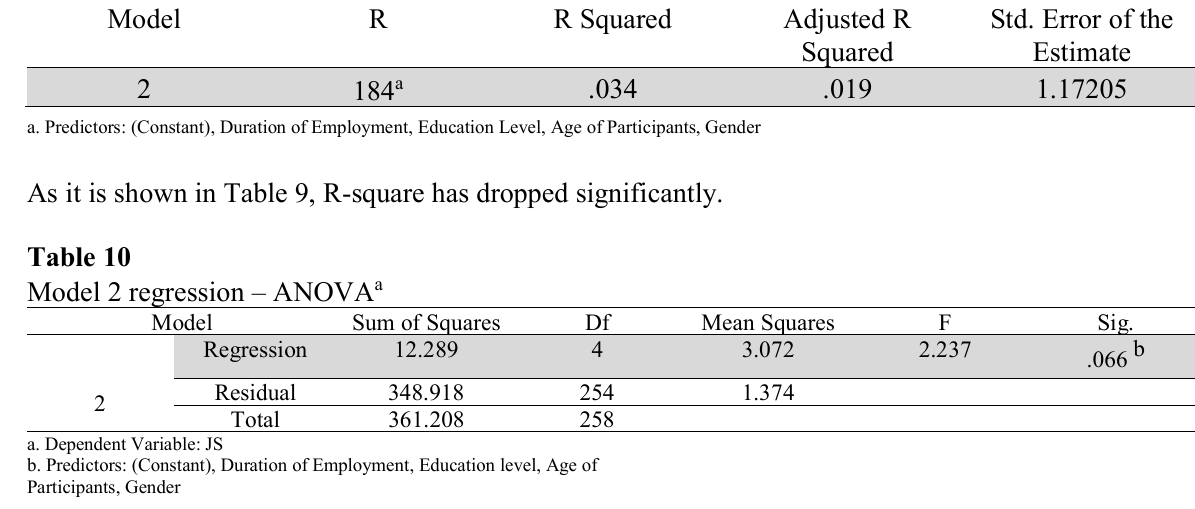
Model 2 Summary